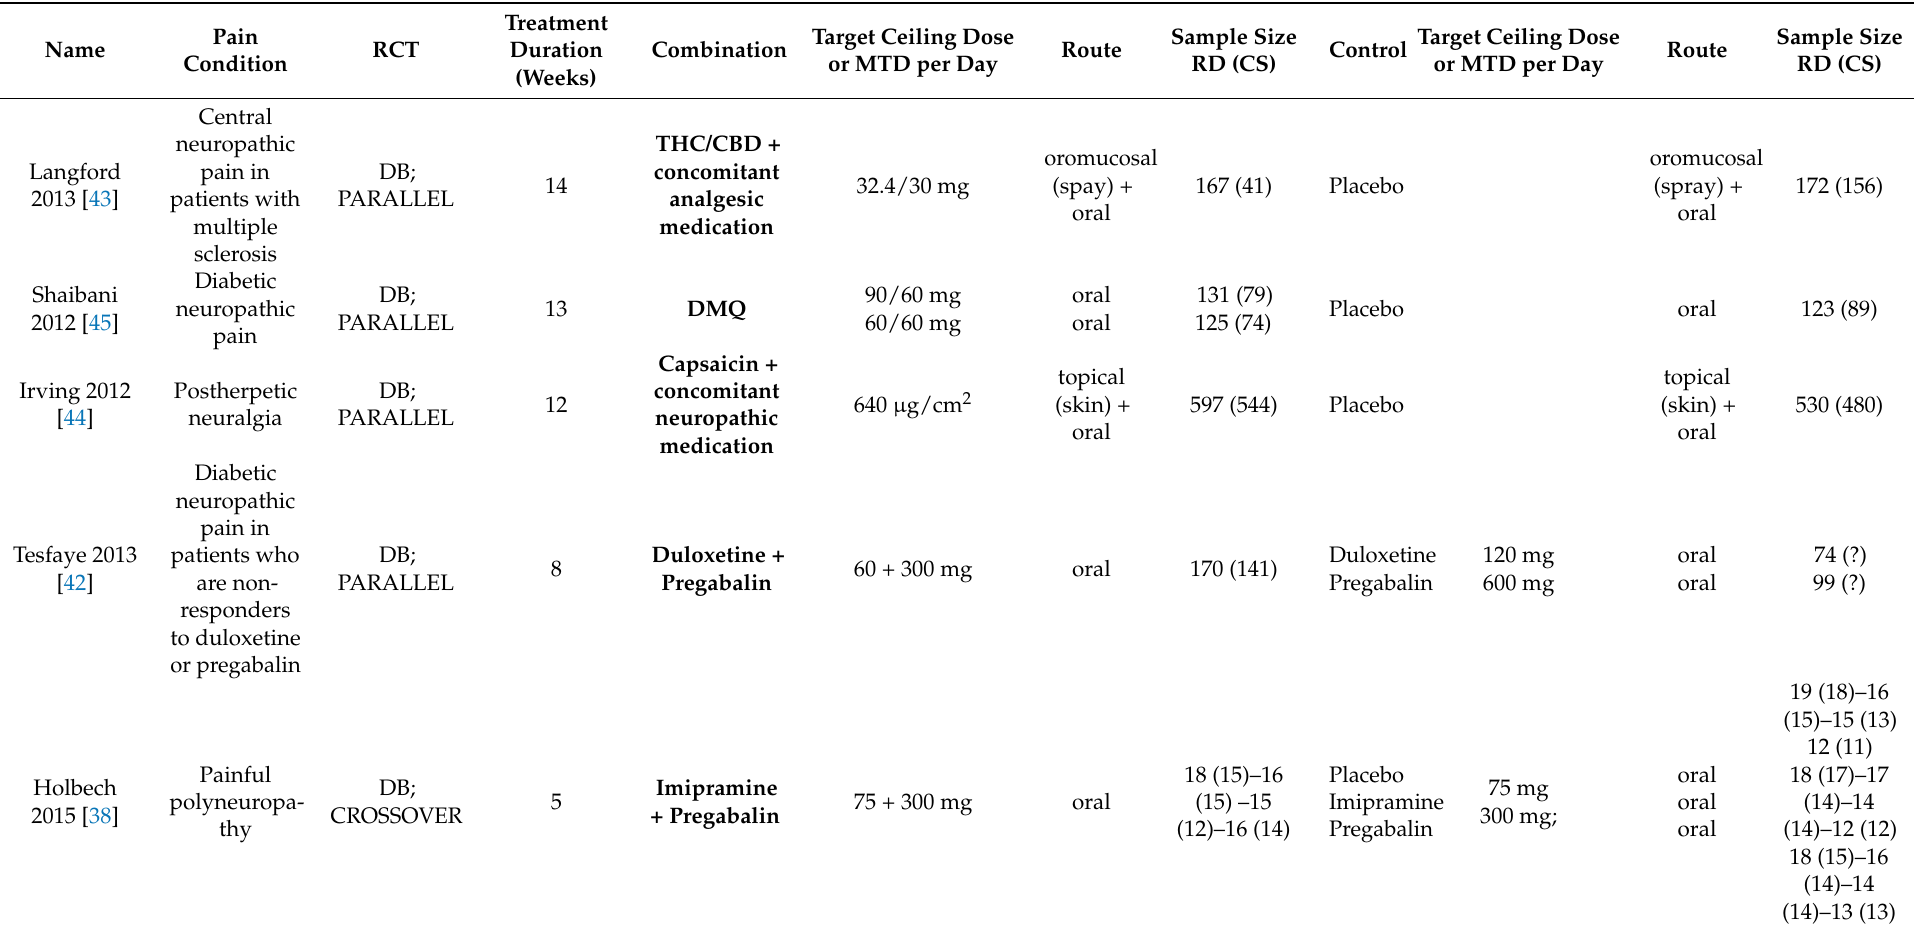
Table 1. Data from the selected